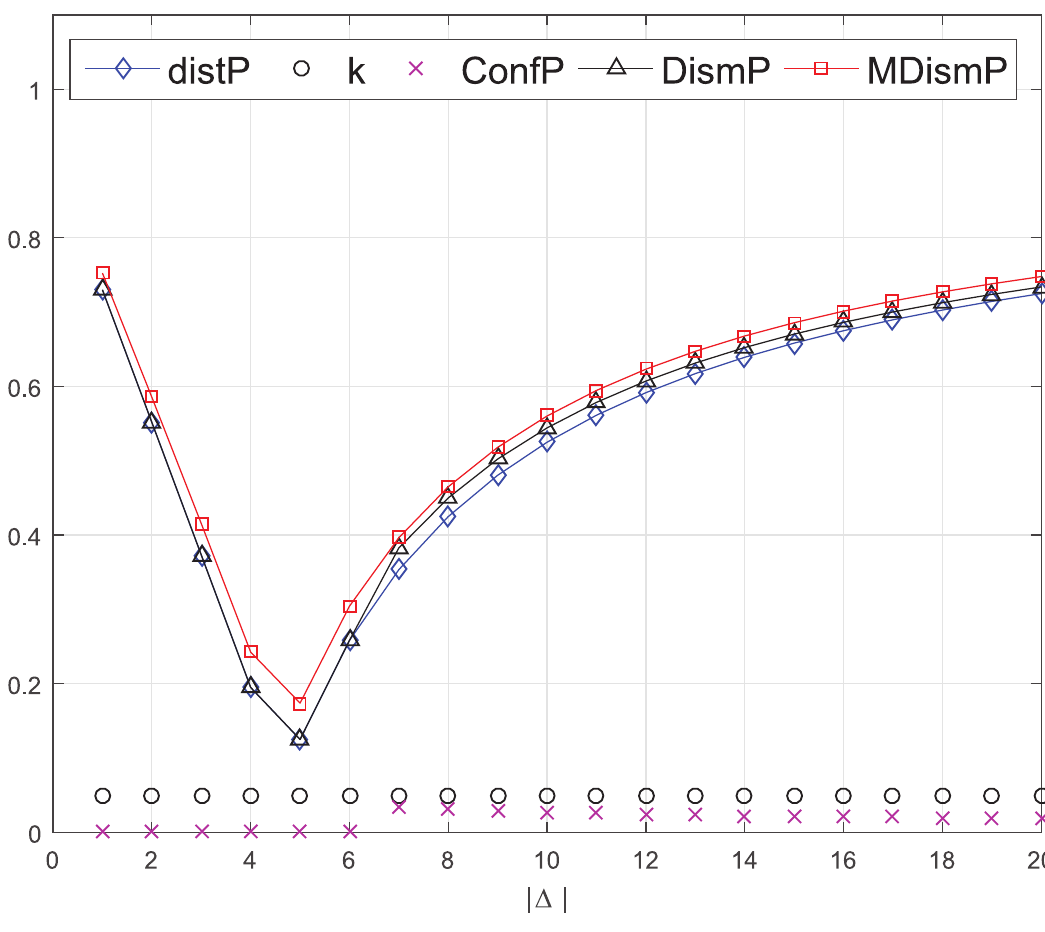
Fig 4. Comparison of dissimilarity of the 1st pair